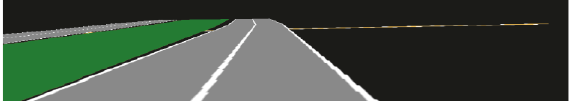
Figure 5: Results of the high-level interpretation